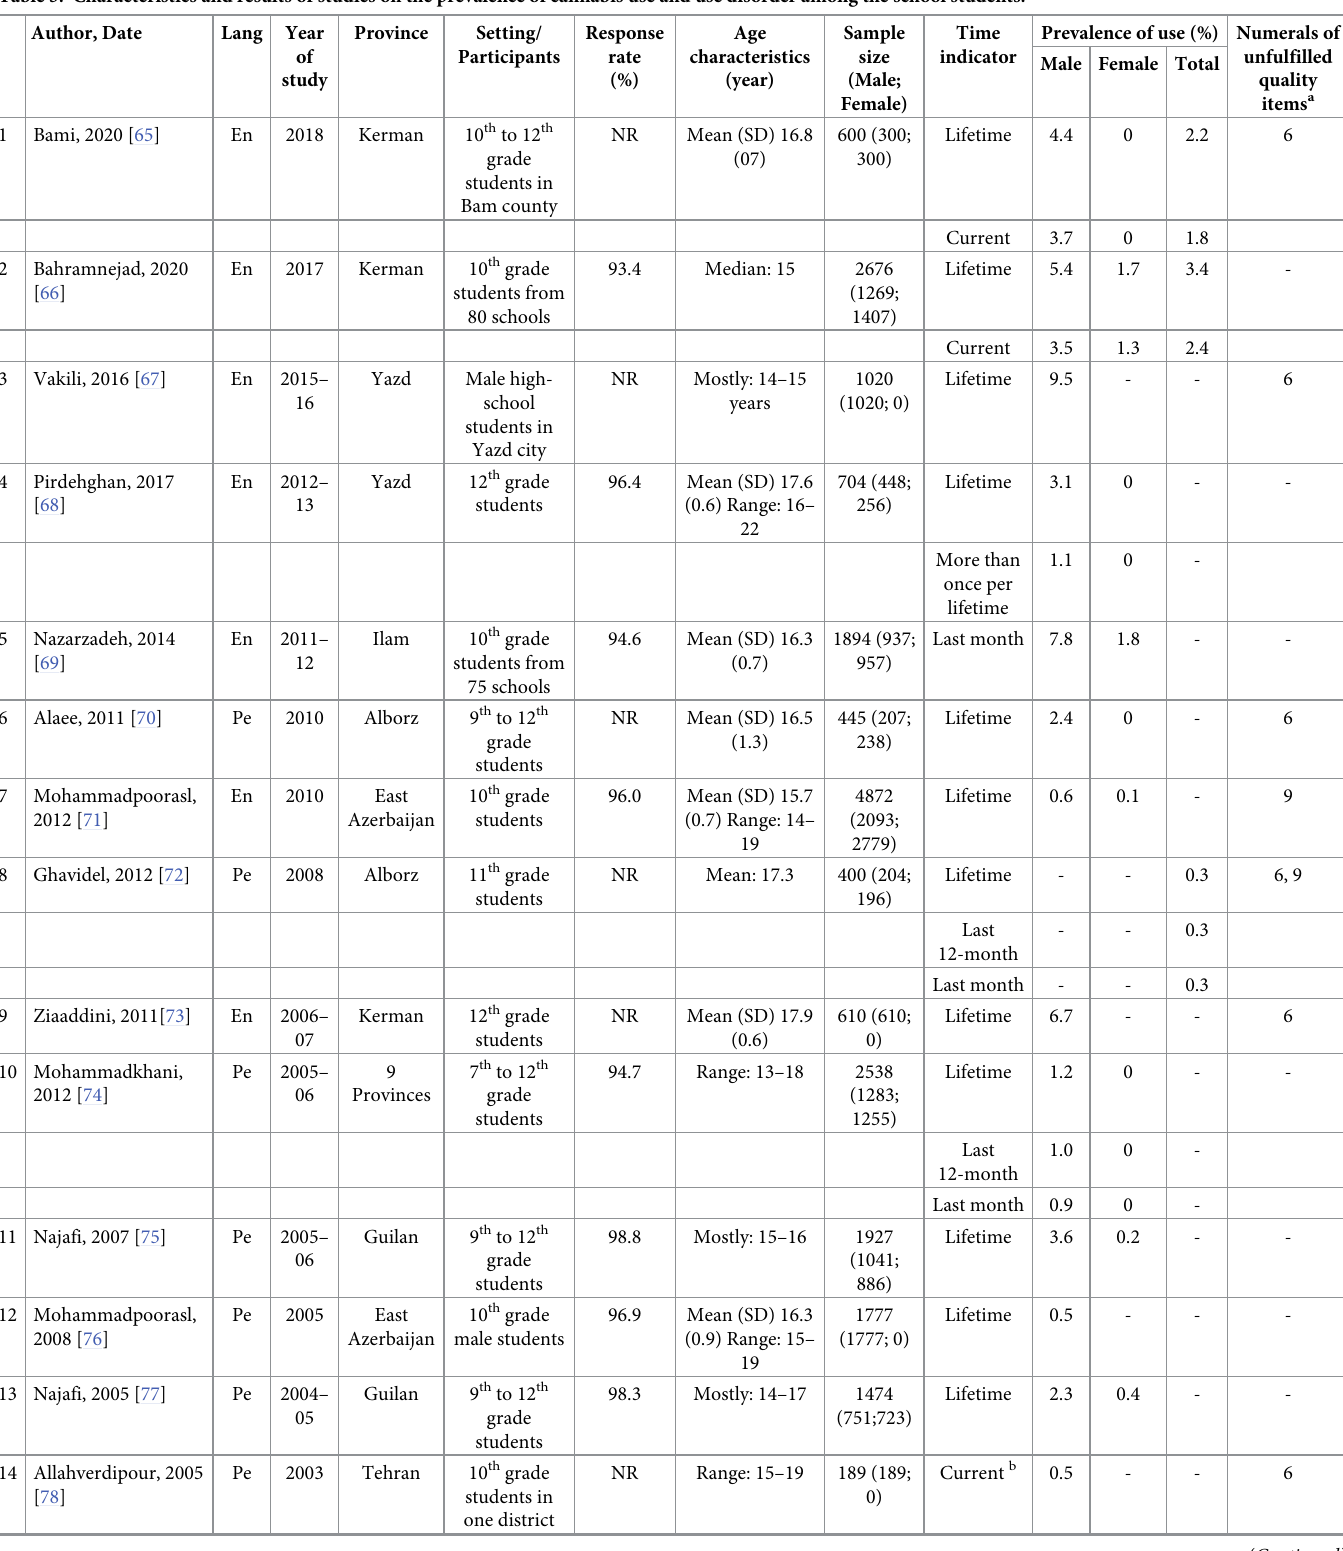
Table 3. Characteristics and results of studies on the prevalence of cannabis use and use disorder among the school